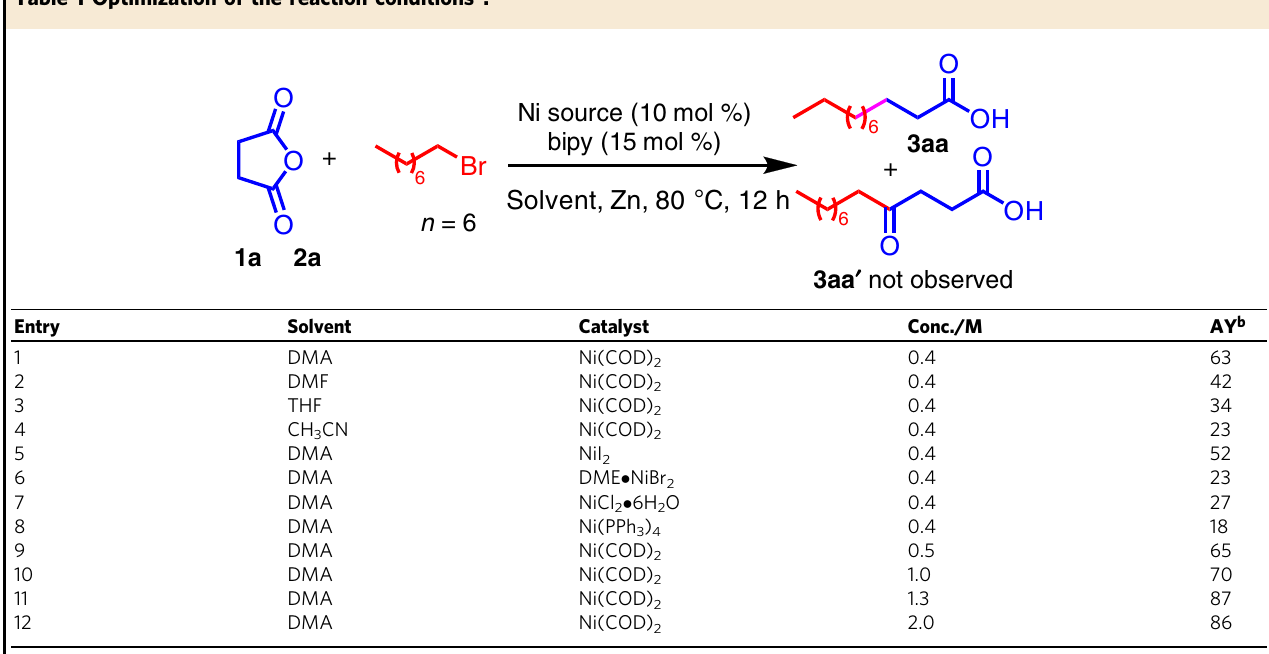
Table 1 Optimization of the reaction conditions a .